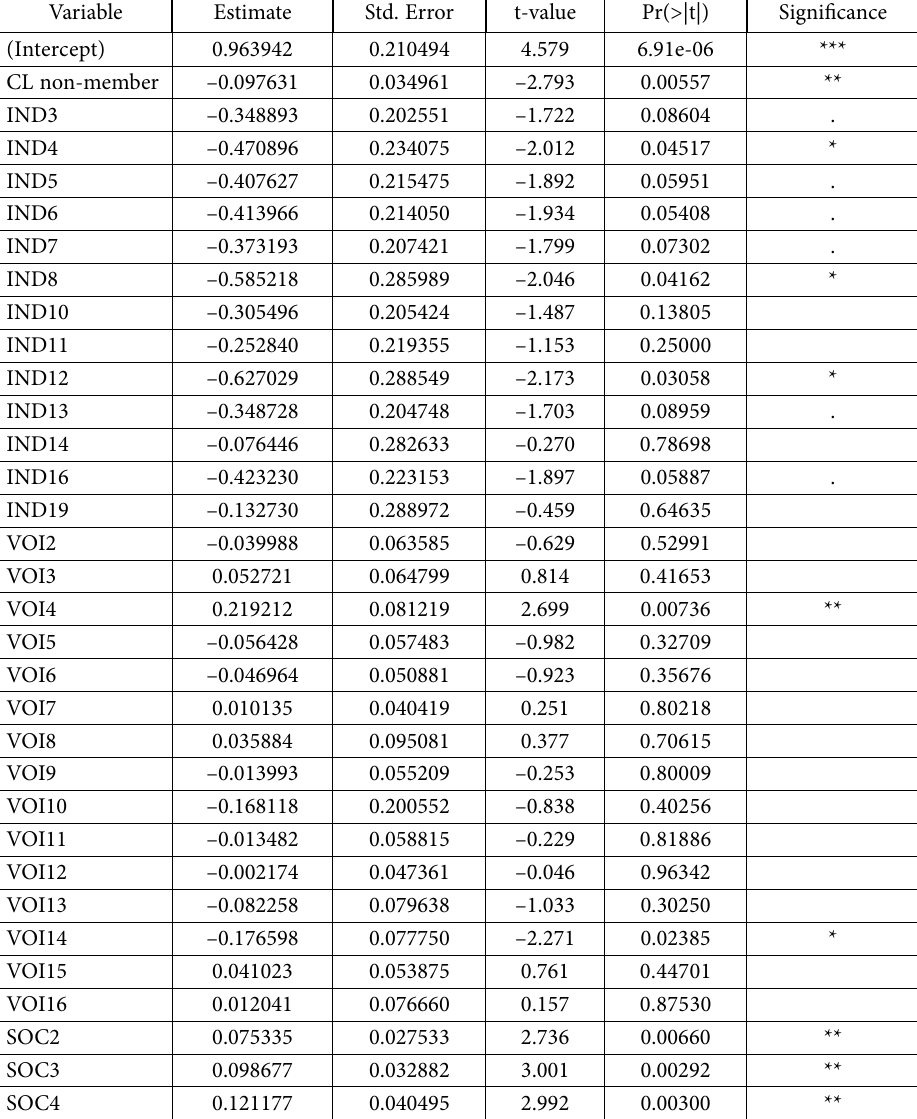
Table 1A. Results of the estimation of control variables (source: own calculation)